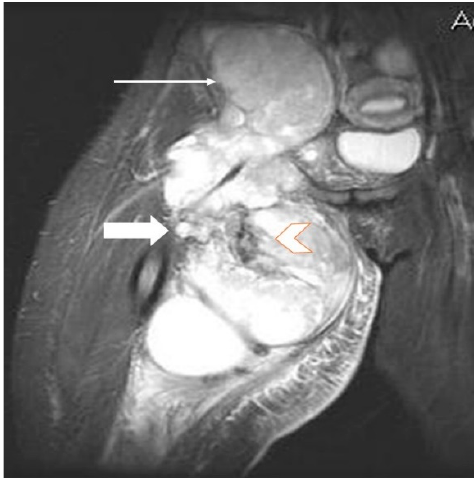
Figure 3. Same patient as in Figures 1 and 2, MR image, coronal T2 STIR (short-time inversion recovery): heterogeneous soft tissue mass showing a mixture of solid areas (line arrow), hemorrhage and/or necrosis (block arrow), calcifications or fibrosis, cystic elements and infiltration of adjacent fat. Furthermore, fluid–fluid levels (block arrow) can be observed in this figure.